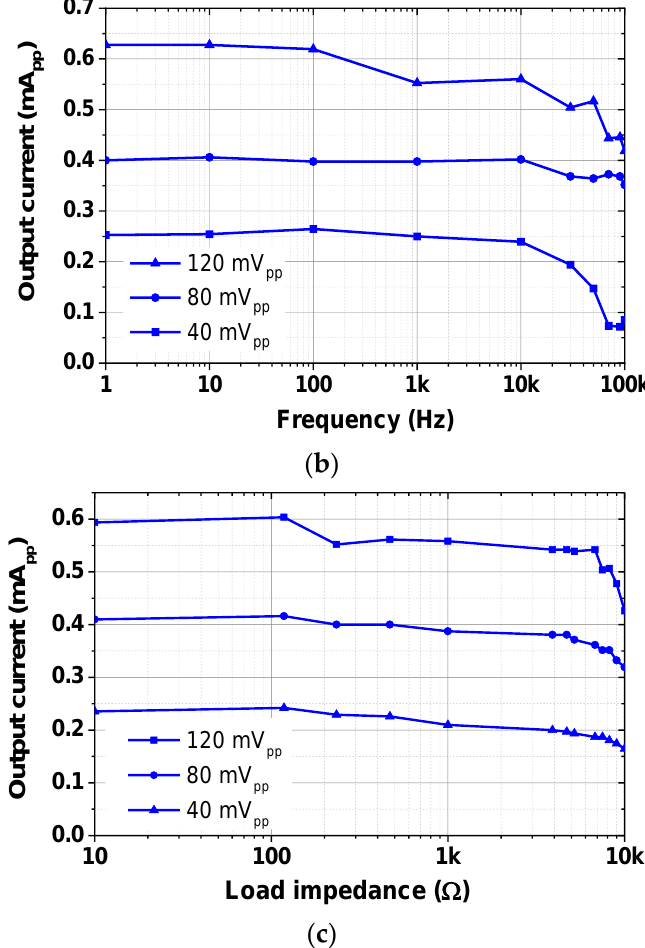
Figure 19. ( a ) Schematic of characterizing the output impedance. ( b ) Measured output current as a function of frequency under different inputs. ( c ) Measured output current as a function of load impedance under different inputs.